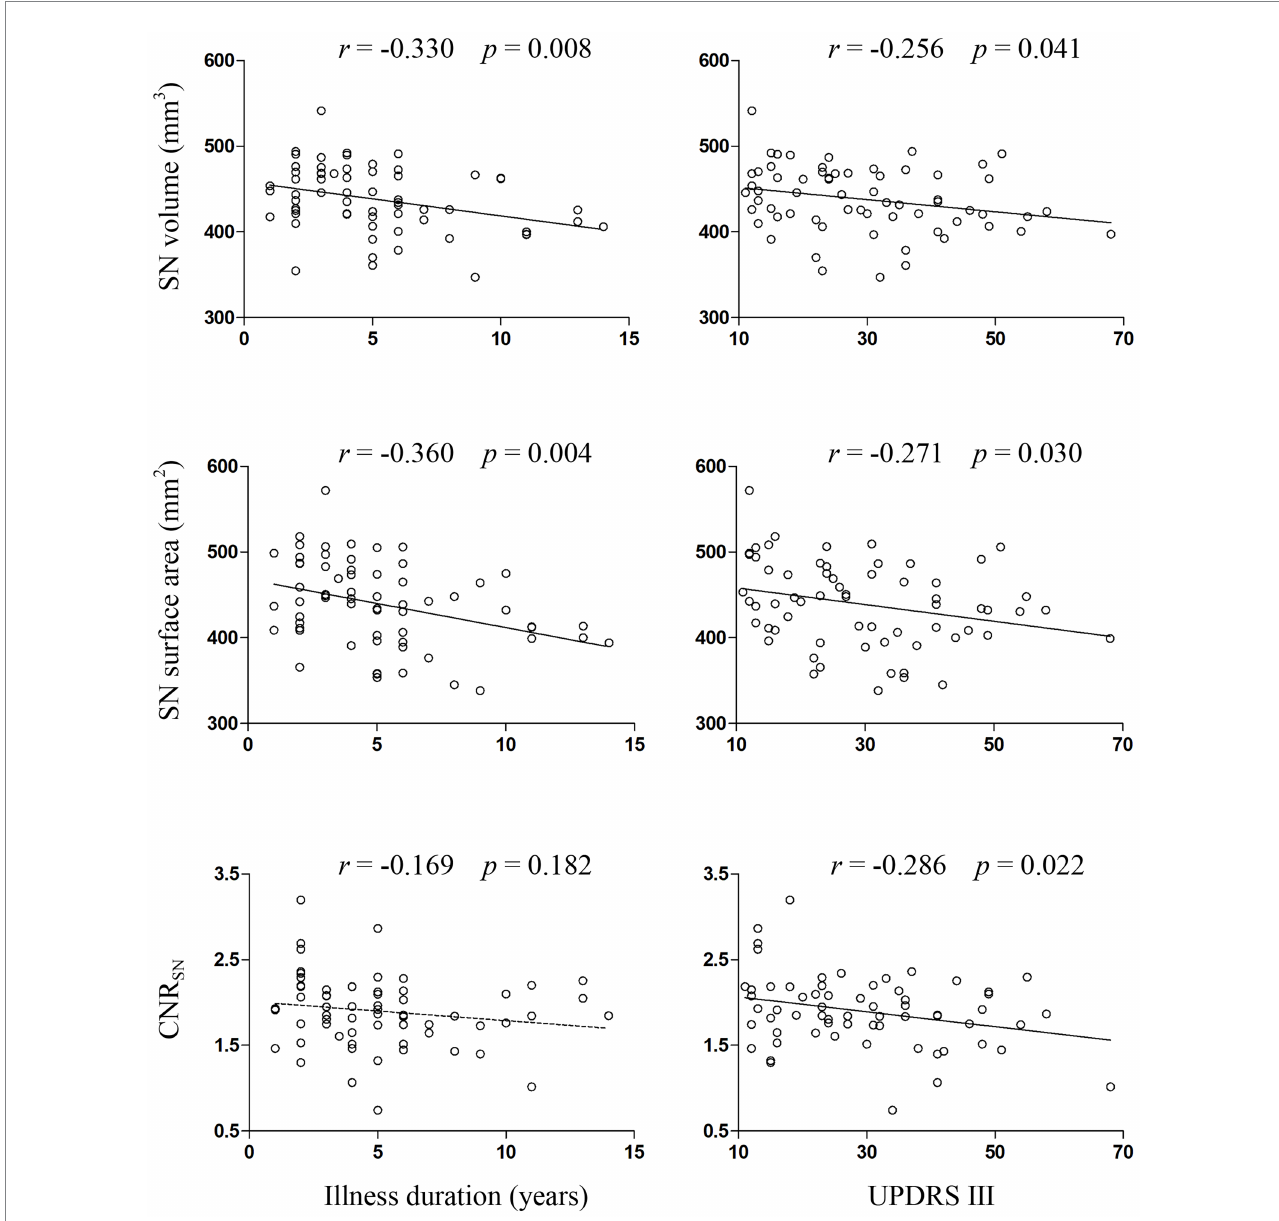
FIGURE 3 Correlations between measures of SN and clinical variables in PD patients. CNR, contrast to noise ratio; SN, substantia nigra; UPDRS III, Unified Parkinson’s Disease Rating Scale part